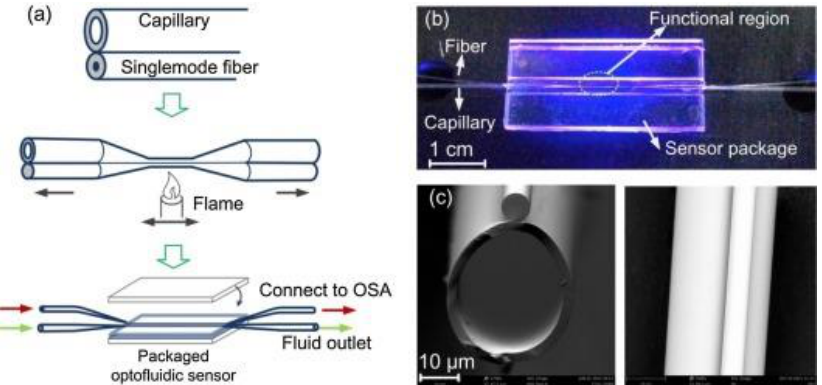
Figure 16. Microfiber-capillary optofluidic sensor fabricated by Liang et. al ( a ) Schematic diagram of the fabrication process of the sensor. ( b ) Image of the sensor platform. ( c ) SEM image of the cross-section and side view of the sensor. Reproduced with permission from [79]. Copyright Elsevier, 2017.